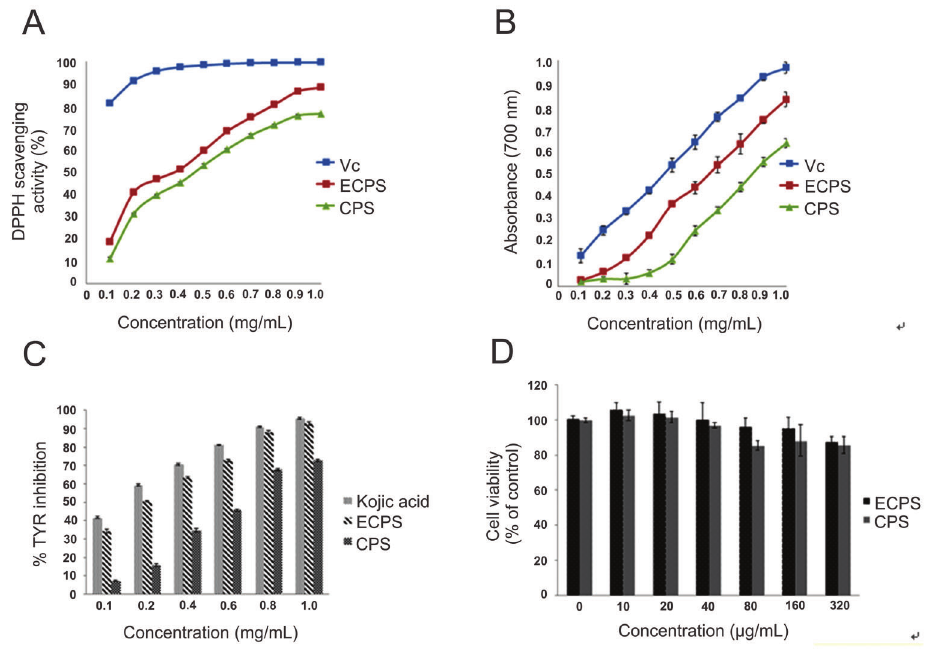
Figure 2. Antioxidant and anti-tyrosinase effects of polysaccharide fragments. A, DDPH scavenging activity. B , Ferric iron reducing power. C , Tyrosinase (TYR) inhibition rates compared with positive control (Kojic acid). D , Effects of ECPS and CPS on B16F10 cells viability. Data are reported as means ± SD (n=3). ECPS: enzymatically hydrolyzed Cuscuta chinensis polysaccharides; CPD: Cuscuta chinensis polysaccharides; Vc: positive